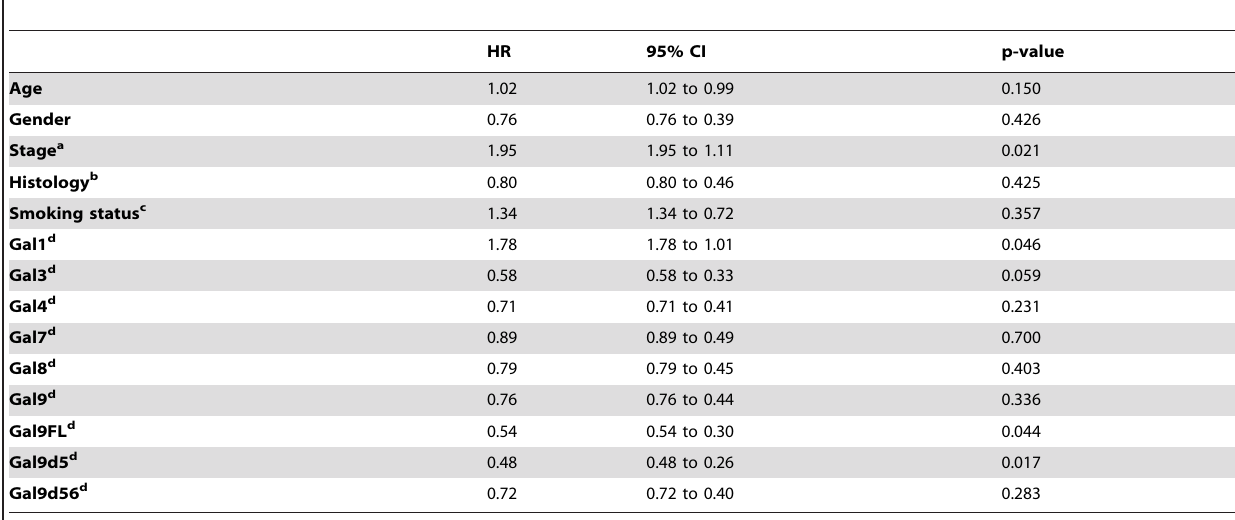
Table 3. Univariable analyses of standard clinical variables and galectin mRNA expression levels in relation to disease free survival in 87 patients with early stage